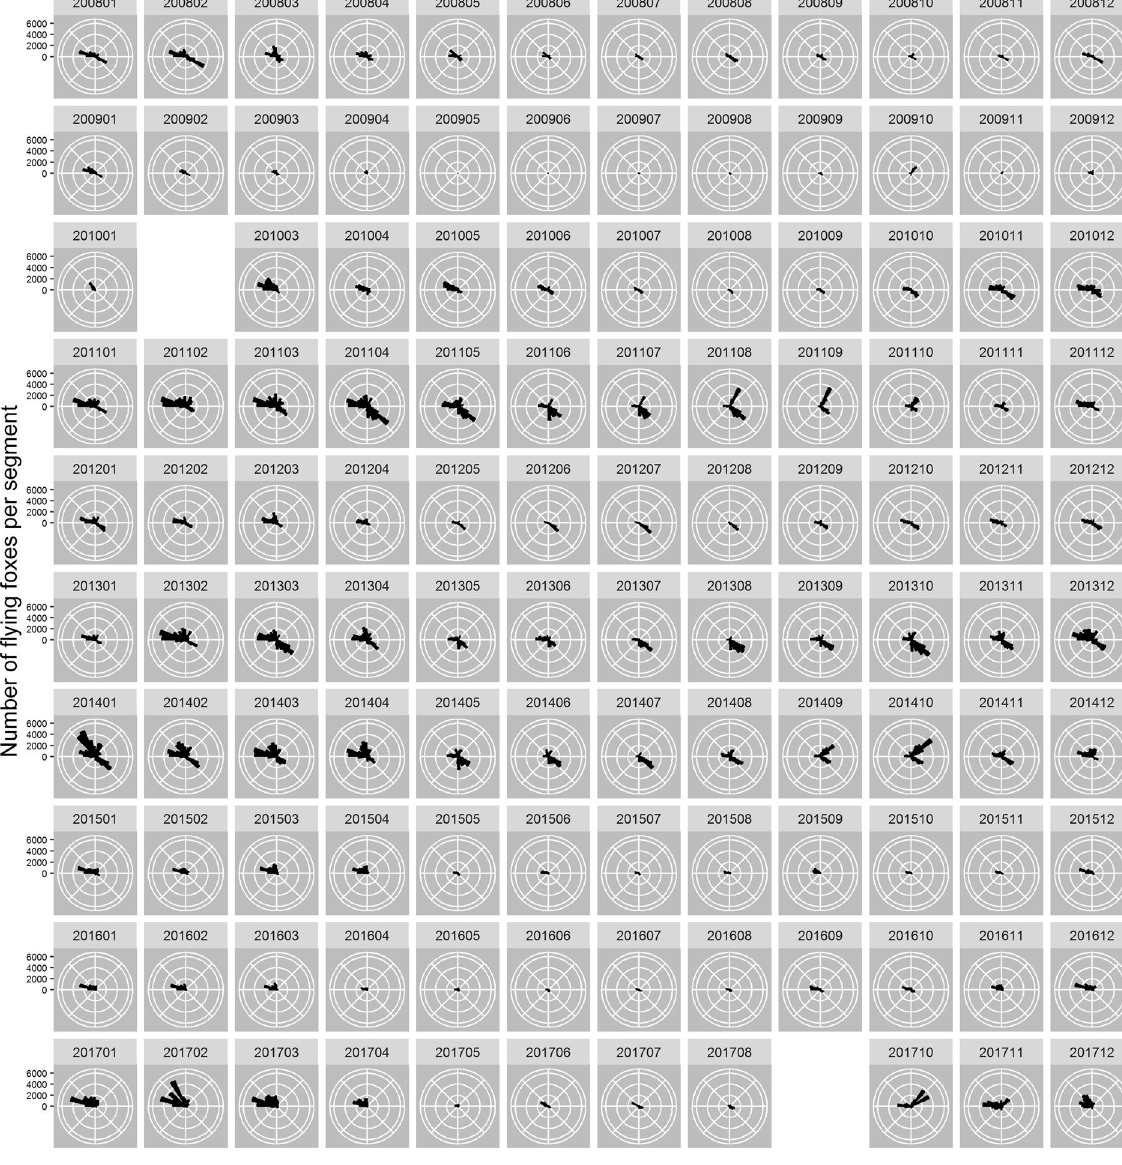
Figure 4. The mean numbers of flying-foxes detected by radar flying out in different directions from the Yarra Bend roost for each month of each